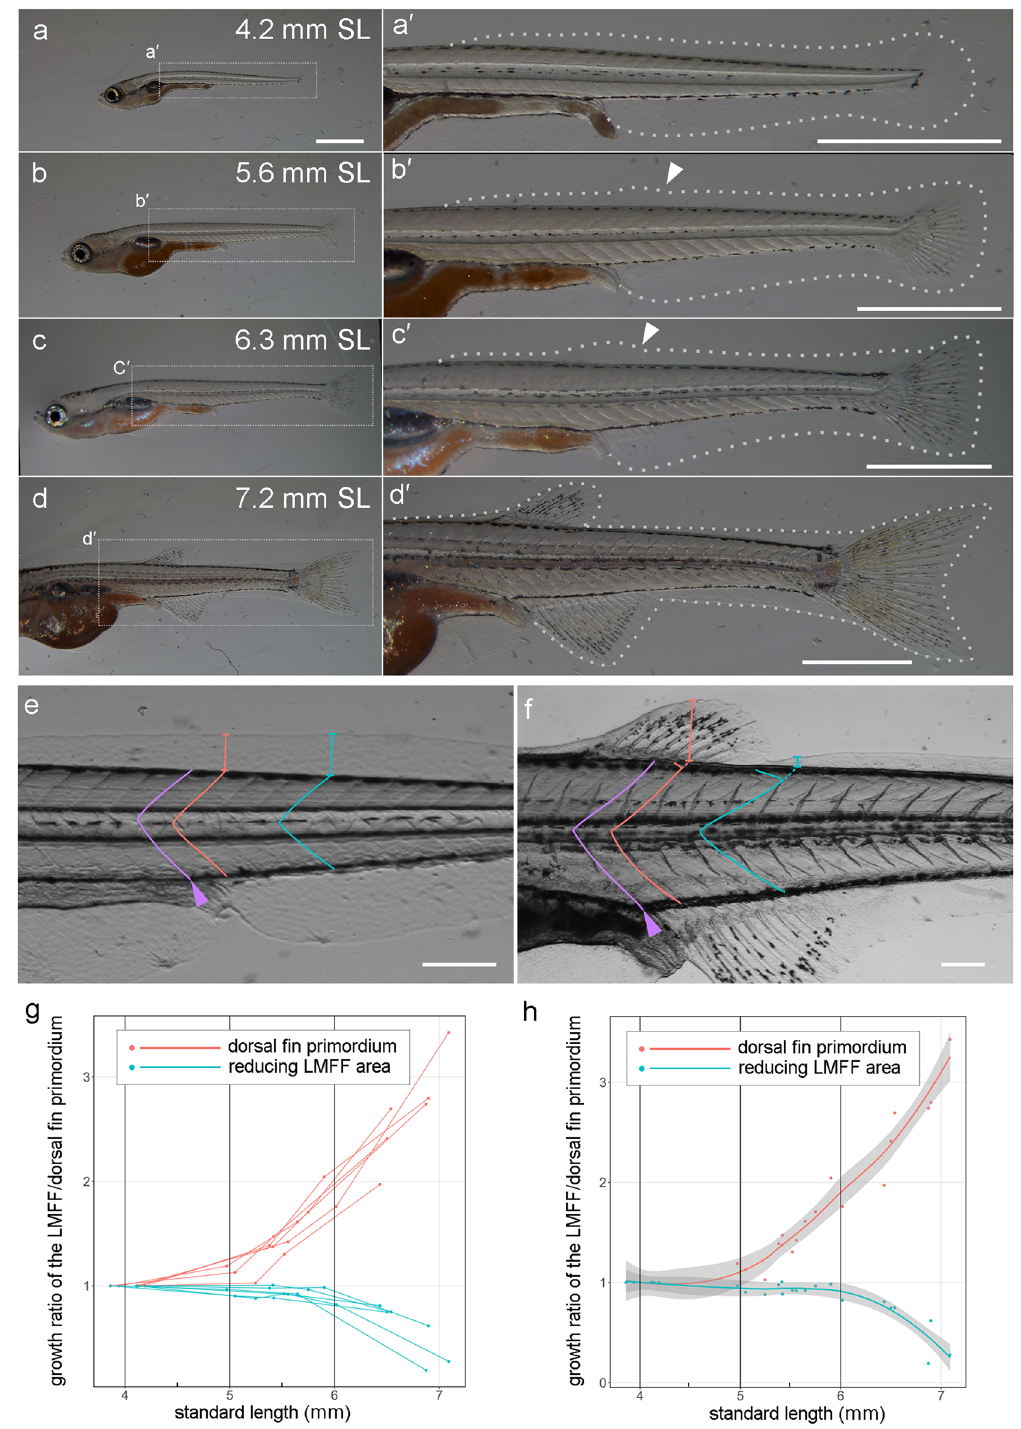
Figure 1. Morphological observation of dorsal fin development and LMFF reduction. ( a - d’ ) Gross anatomy of median fin development at 4.2 mm ( a , a’ ), 5.6 mm ( b , b’ ), 6. 3 mm ( c , c’ ), and 7.2 mm ( d , d’ ). The right panels ( a’ , b’ , c’ , d’ ) are magnified views of the dashed rectangles in the left panes ( a , b , c , d ), respectively. White dashed lines in ( a’ , b’ , c’ , d’ ) indicate outlines of the LMFF. White arrowheads in ( b’ , c’ ) indicate protrusion sites of the LMFF. ( e , f ) Landmark and positions used for measuring the height of the LMFF. To examine the height of the LMFF/dorsal fin primordium at the same position during ontogeny, we used the somite boundary, which is located at the gut tube bending point (purple arrowhead) as a landmark (the first boundary: purple line). Then, we measured two somite boundaries: the next somite boundary from the first boundary (red line) for the future dorsal fin position and the fifth somite boundary (blue lines) for the fin-disappearing positions, respectively. ( g , h ) Transition of growth ratio of the LMFF/dorsal fin primordium. Each line in ( g ) indicates temporal transition of the same individual. ( h ) Local polynomial regression fit of ( g ). The 95% confidence intervals are indicated as grey areas in ( h ). Scale bars in ( a ) and those in ( a’ , b’ , c’ , d’ , e , f ) indicate 1 mm and 200 μm,